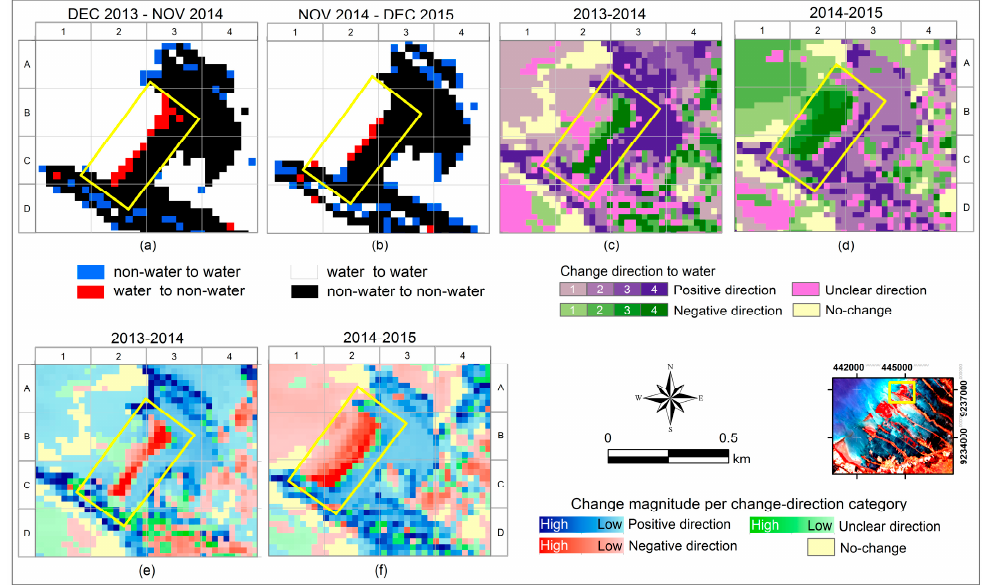
Figure 11. An example of comparison results between post classification comparison and CVA method. Both methods agree on change results of the area in yellow polygons that show a change from water to non-water ( a , b ) which equal to negative direction ( c , d ) with high change magnitude ( e , f ).